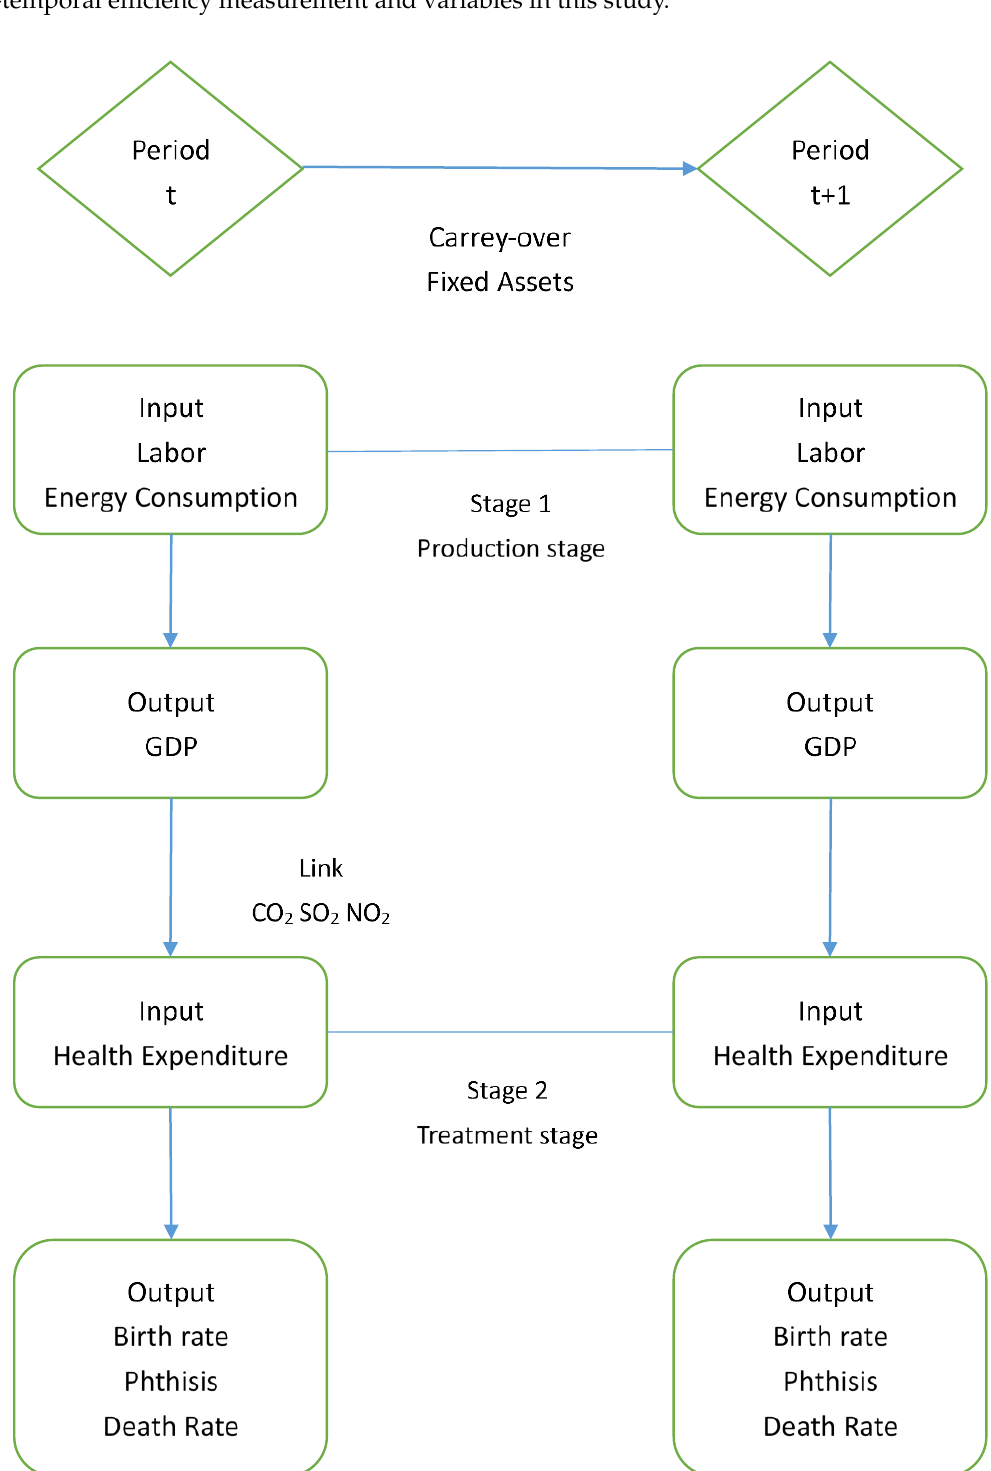
Figure 2. The structure of dynamic Network model.